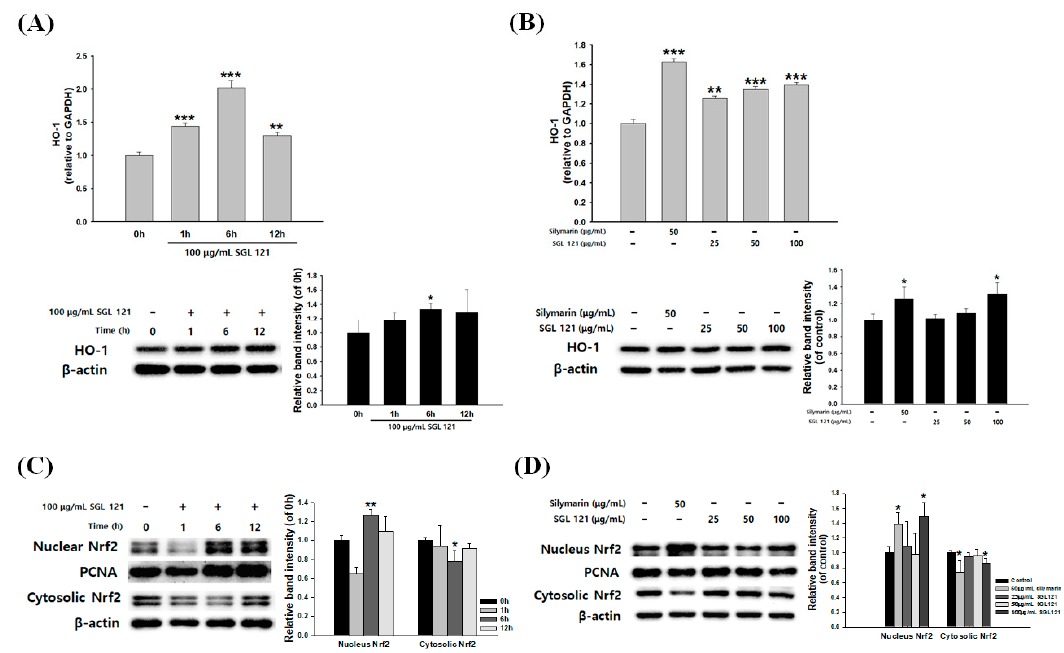
Figure 7. Effects of SGL 121 on HO-1 expression and Nrf2 nuclear translocation in HepG2 Cells. ( A ) Time-course analysis of mRNA and protein expression of HO-1 at 100 µ g / mL SGL 121, ( B ) analysis of mRNA and protein expression of HO-1 after 6 h treatment of 25, 50, and 100 µ g / mL SGL 121, ( C ) time course analysis of Nrf2 levels in nuclear and cytosolic extracts at 100 µ g / mL SGL 121, and ( D ) analysis of Nrf2 levels in nuclear and cytosolic extracts after 25, 50, and 100 µ g / mL SGL 121 treatment for 6 h. Data are presented as the mean ± SD. * p < 0.05, ** p < 0.01 and *** p < 0.001 compared to the control.